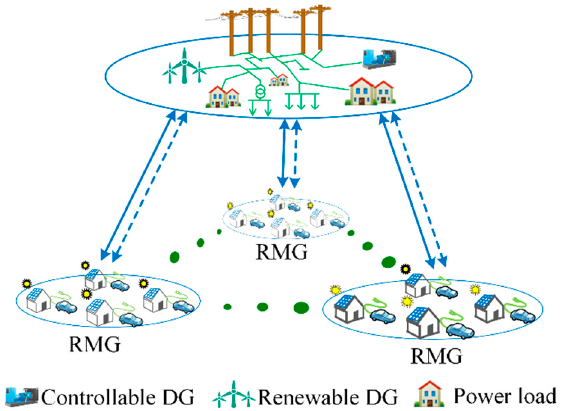
Figure 2. The hierarchical structure of active distribution network (ADN) connected with Multi-RMGs, where the solid line with arrows represents the power flow and the dashed line with arrows represents information flow.